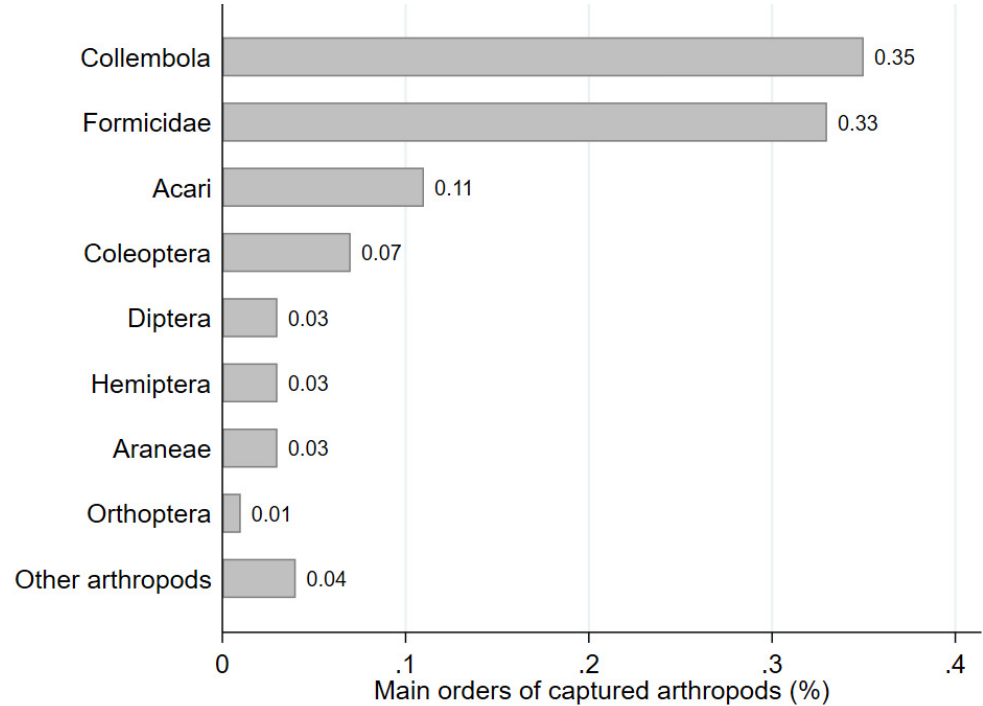
Fig 2 . Identified arthropod orders in repeated captures in pitfall traps. El Mira Research Center, Tumaco, Pacific Coast of Colombia, 2017.